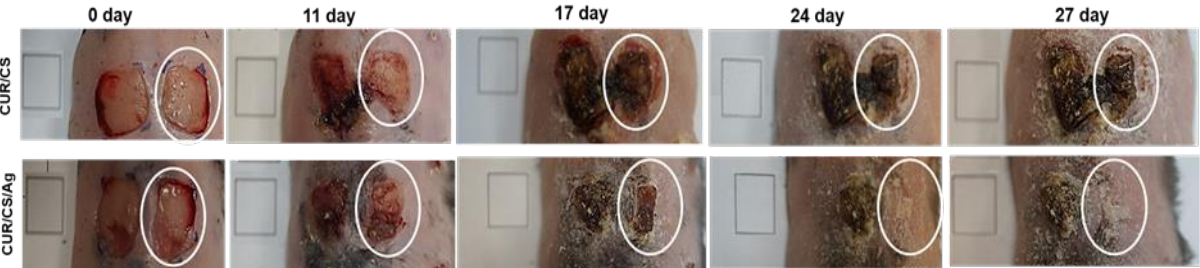
Figure 9. The representative photographs showing the healing dynamic of full-thickness skin with ( right wound ) or without ( left wound ) treatment with curdlan/chitosan and curdlan/chitosan/Ag foams, for each of the groups of animals, n = 3. The ovals show the foams of the treated wounds. Wounds were covered with biomaterials for 10 days, after which healing occurred without the influence of biomaterials.